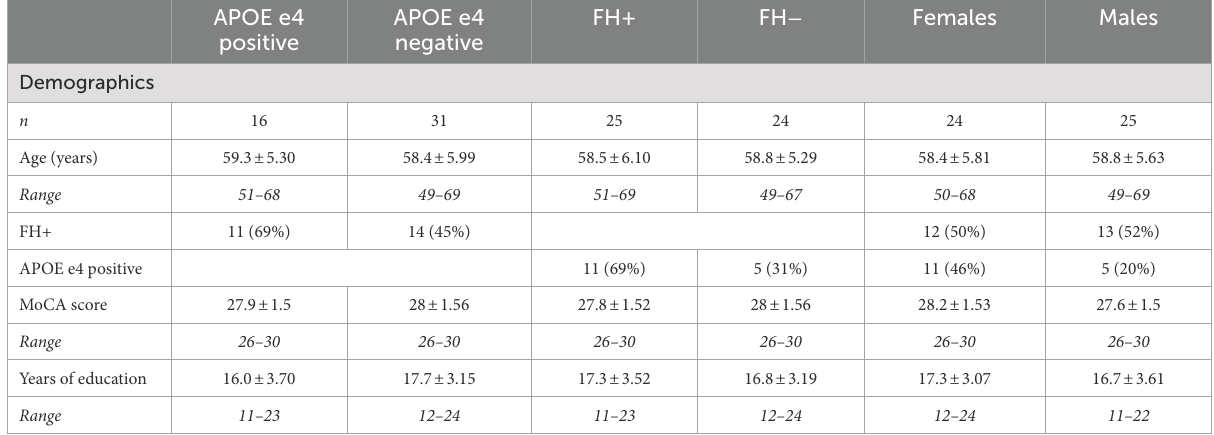
TABLE 1 Participant demographic